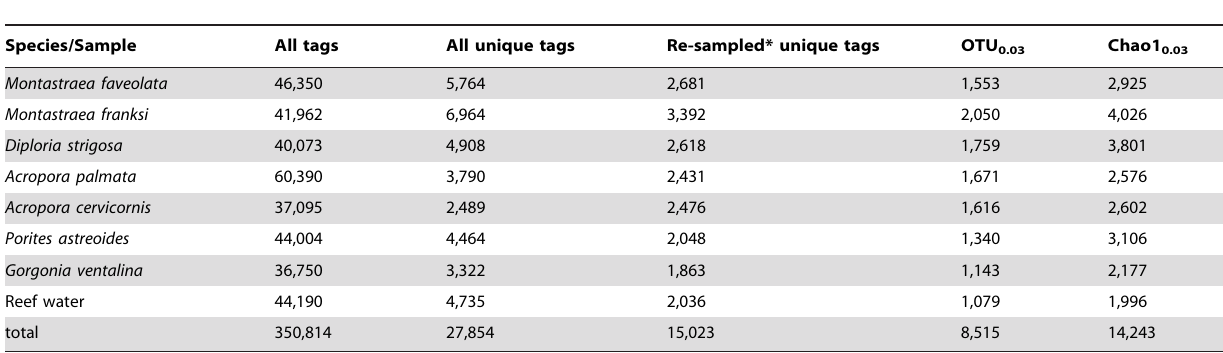
Table 1. V6-tag sequencing statistics and species richness